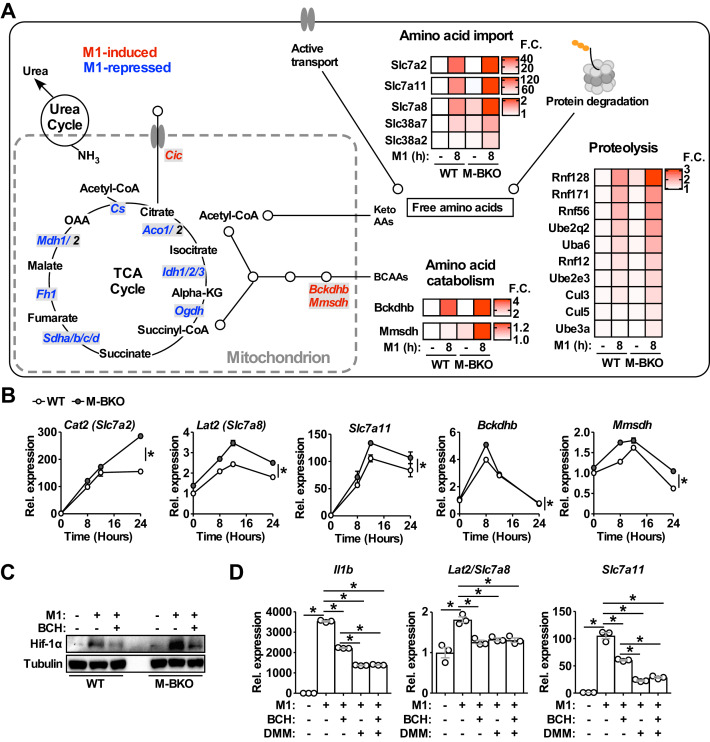
Genes involved in amino-acid uptake and catabolism are upregulated in M-BKO macrophages.(A) Schematic representation of M1-regulated genes involved in amino-acid and TCA metabolism determined by RNA-seq. Genes in blue are downregulated whereas genes in red are upregulated by 8 hours M1 activation in both WT and M-BKO macrophages. Genes that are differentially regulated in these two genotypes are displayed in heat maps on the right. F.C., fold change. N = 3 biological replicates. BCAAs, branch chain amino acids; Keto AAs, ketogenic amino acids; Cic, mitochondrial citrate carrier. (B) Relative expression of differentially regulated genes identified by RNA-seq and validated by qPCR in a 24-hr time course of M1 activation. N = 3 biological replicates, statistical analysis was performed using two-way ANOVA for WT vs M-BKO across the time course. (C) Hif-1α protein levels in control or 6-hr M1-activated macrophages with or without co-treatment of the neutral amino-acid transport inhibitor 2-amino-2-norbornanecarboxylic acid (BCH, 10 mM). (D) Gene expression in control or 6-hr M1-activated macrophages with or without co-treatment of 10 mM BCH and/or the complex II inhibitor dimethyl malonate (DMM, 10 mM) determined by qPCR. N = 3 biological replicates, statistical analysis was performed using Student’s T test. Data are presented as mean ± S.E.M. *, p<0.05. Cell culture experiments were repeated at least twice.Figure 5—source data 1.Functional annotation clustering genes commonly and differentially regulated between WT and M-BKO BMDMs by 8 h M1 activation.